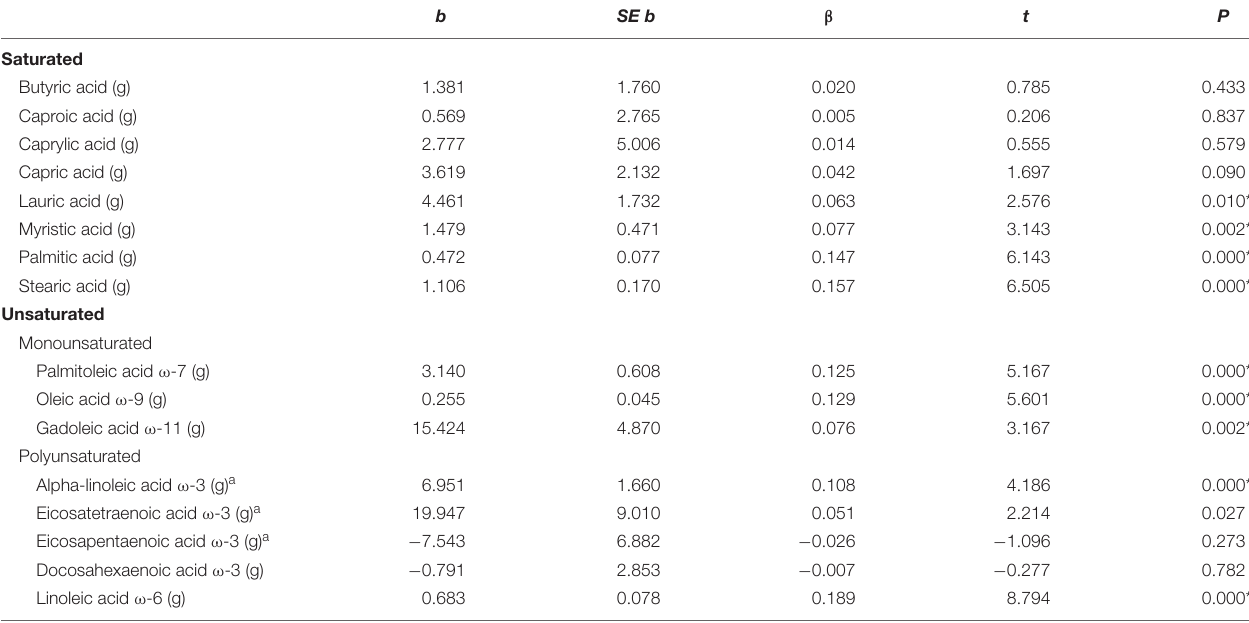
TABLE 6 | Linear regressions between each fatty acid and recollection accuracy (%). b SE b β t